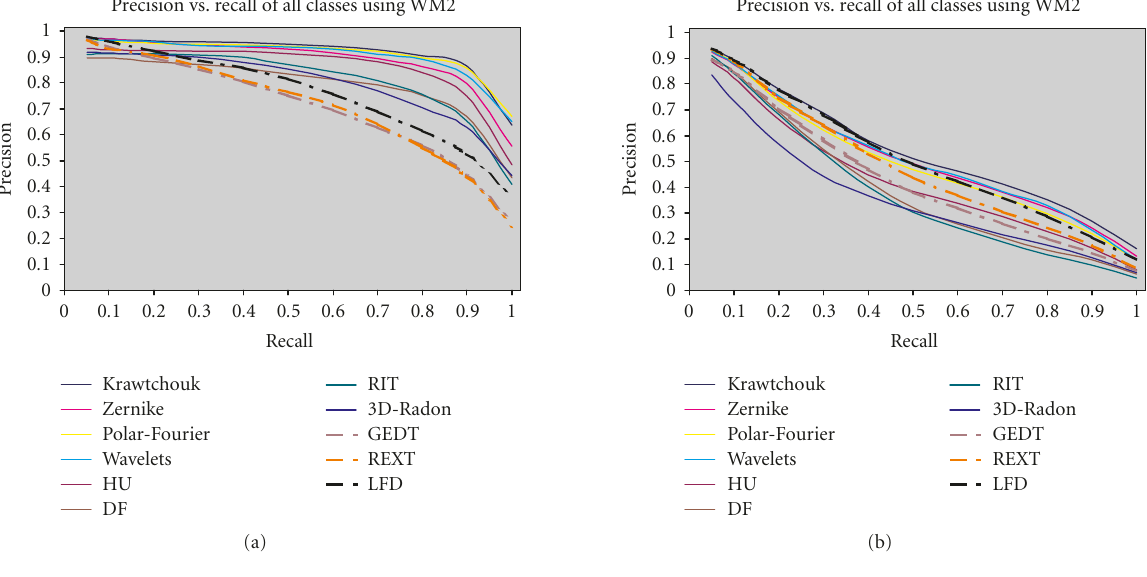
Figure 9: Precision-recall curves diagram using the weight method 2 for the new database (a) and for the Princeton database (b).